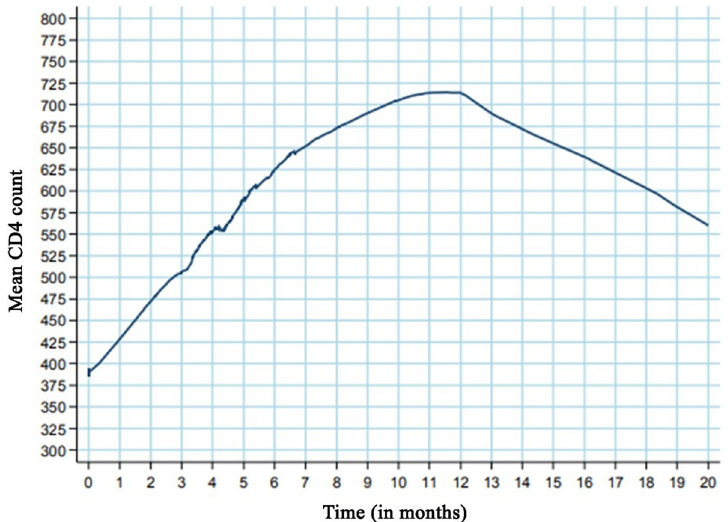
Fig 2. Mean CD4 count from the time antiretroviral therapy was initiated in individuals after the first antiretroviral regimen containing dolutegravir.